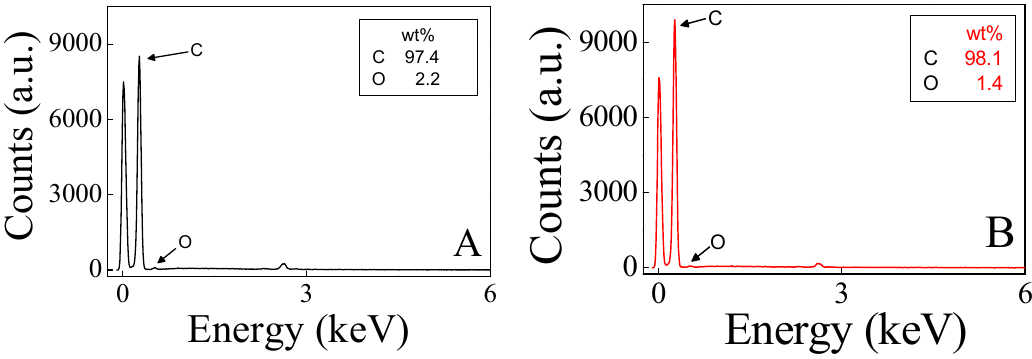
Figure 3. EDS spectra for flexible SPEs before ( A ) and after ( B ) electrochemical pretreatment.